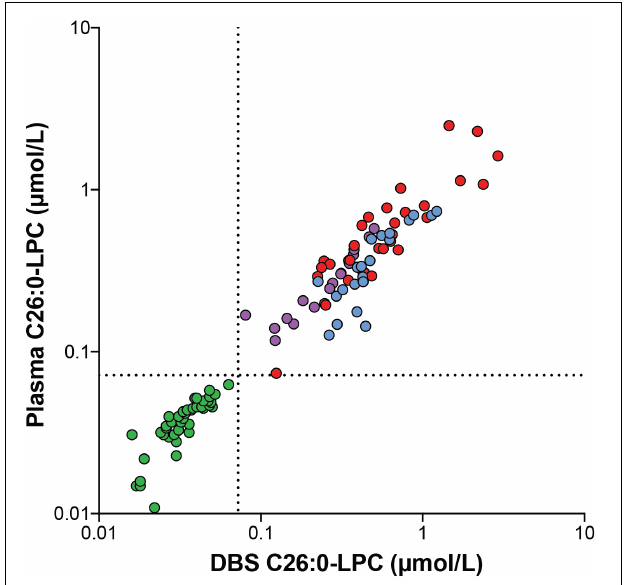
FIGURE 1 | Correlation plot showing the correlation between C26:0-LPC levels analyzed in DBS and plasma samples from controls (green circles, n = 43), ALD males (blue circles, n = 21), ALD females (purple circles, n = 17) and ZSD patients (red circles, n = 33) that were generated from the same blood sample. The upper limit of the reference range (0.072 µ mol/L) is indicated by the dashed lines.